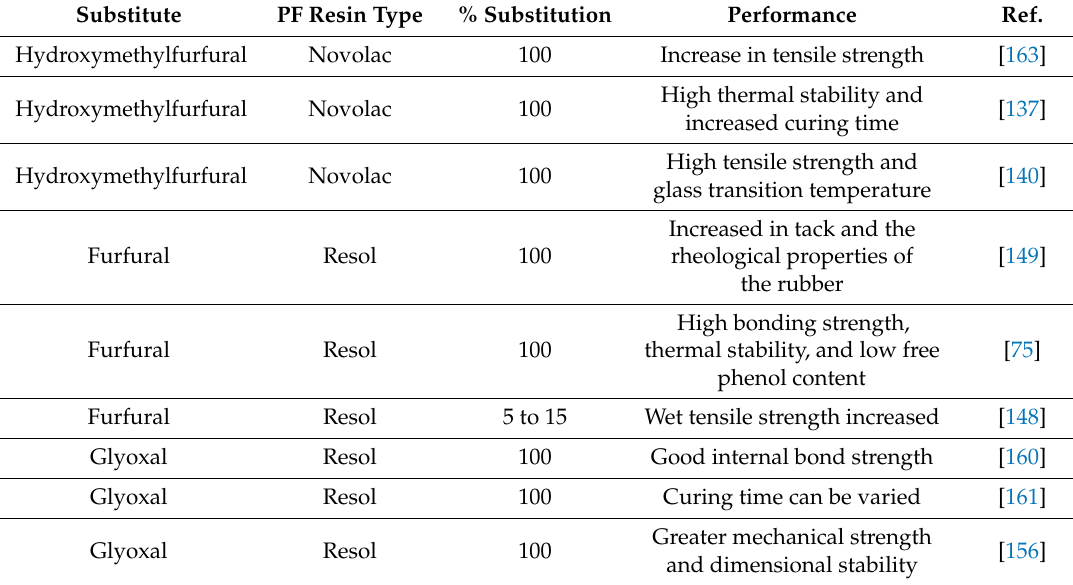
Table 5. Formaldehyde substitutes used in the synthesis of phenolic